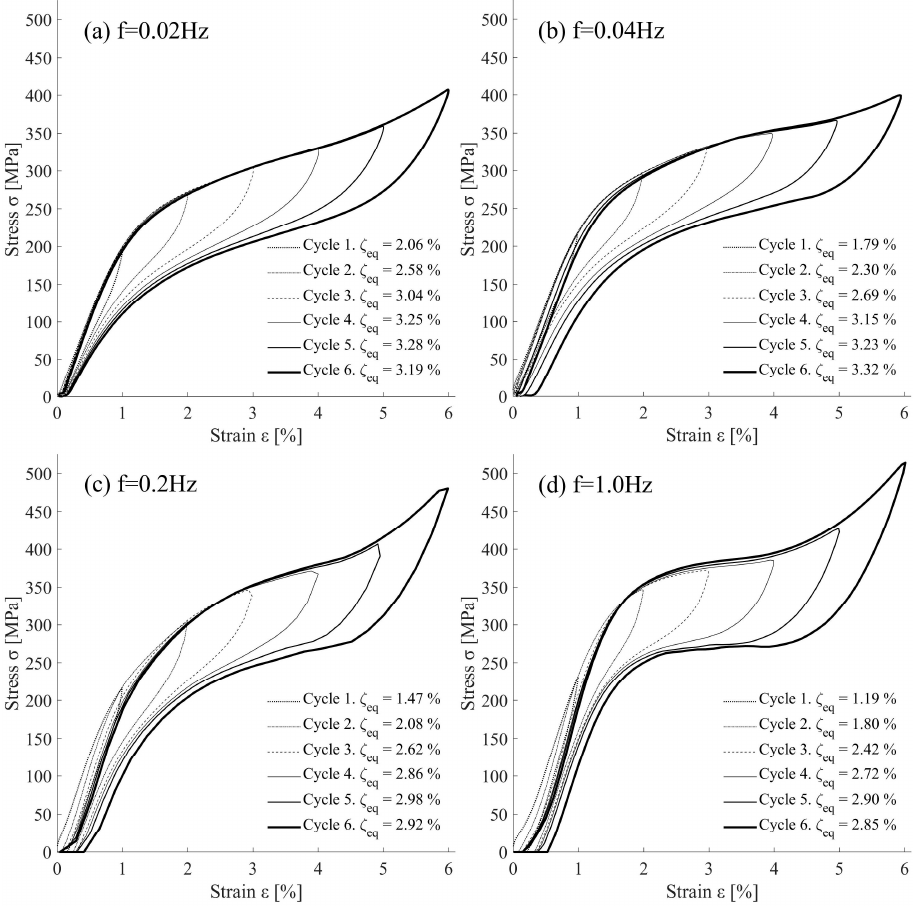
Figure 9. Hysteresis loops of specimens: ( a ) S 21 , ( b ) S 22 , ( c ) D 21 , and ( d ) D 22 .